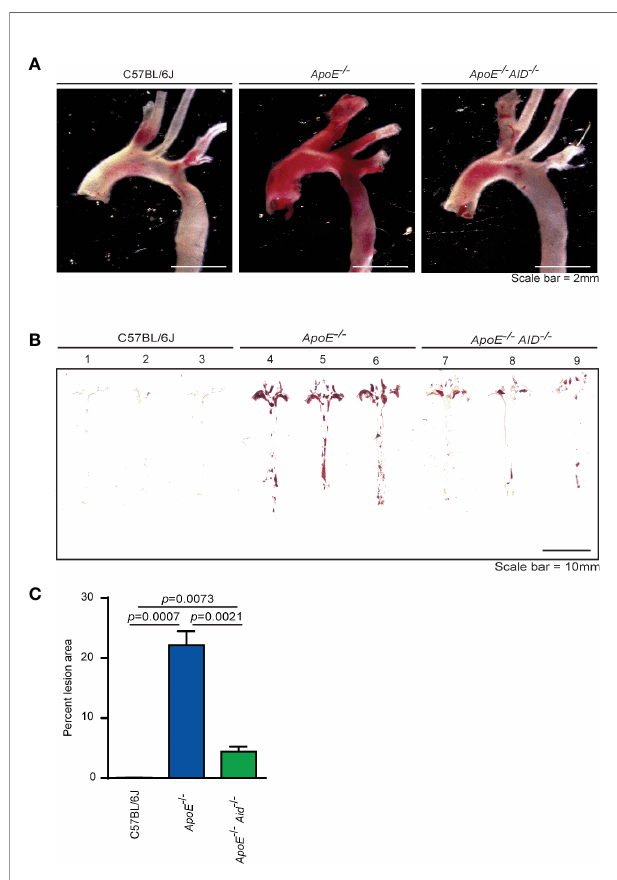
FIGURE 1 | Lipid accumulation in aortas from mice fed a high fat diet for 4 months. (A) Representative images of Oil Red O-stained aortic arch and branches and (B) en face thoracic and abdominal aortas from 3 mice each from C57BL/6J, ApoE -/- and ApoE -/- Aid -/- genotypes. (C) Quanti fi cation of Oil Red O staining area from en face images using HALO software. Error-bars represent standard deviation from a total of 11-15 mice per genotype. Statistics were calculated by two-tailed T-test.